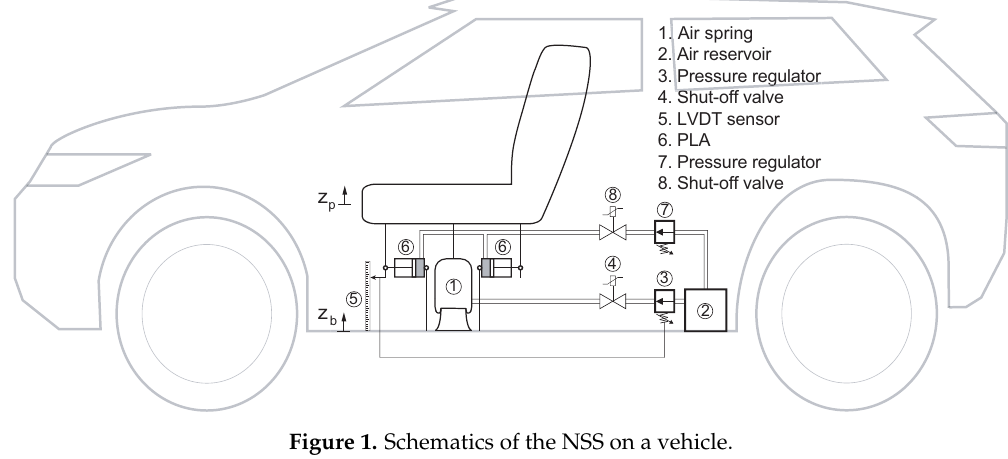
Figure 1. Schematics of the NSS on a vehicle.